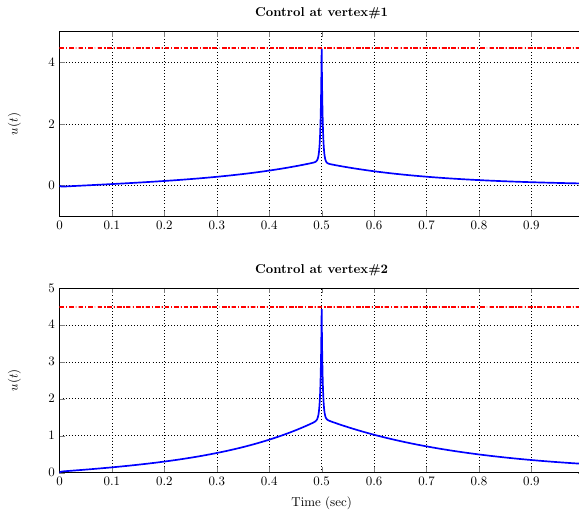
Figure 2: Worst case control response at vertex#1 and vertex#2 √ (cid:112) 20 in the dash-dotted (blue) and the U =